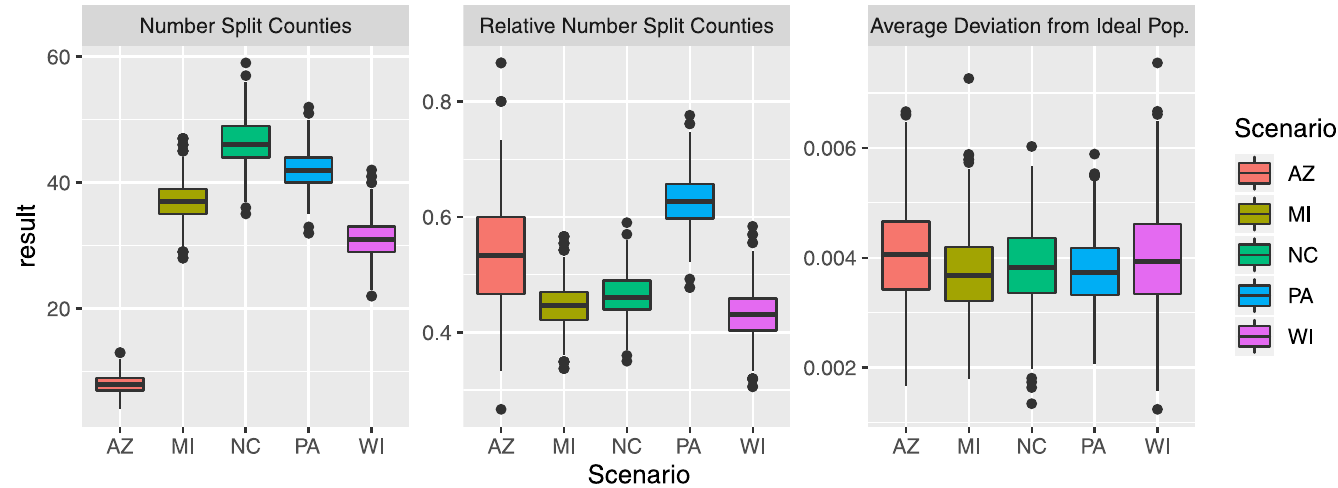
Fig 2. Absolute and relative number (percentage) of counties split, and average deviation from ideal